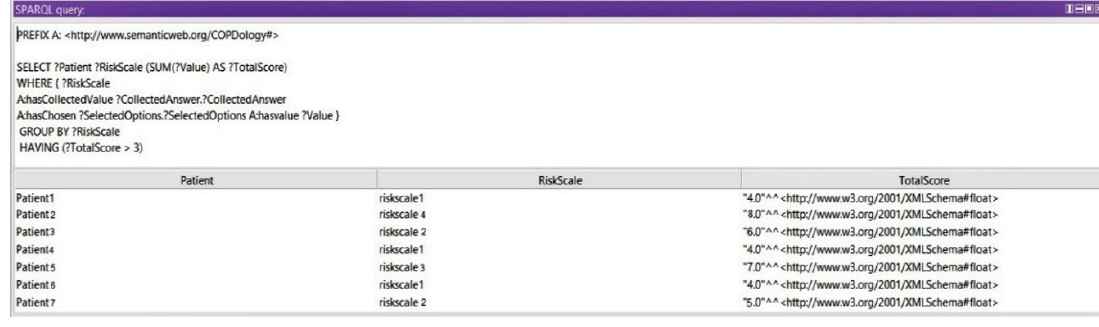
Figure 19. Query 3 and result.